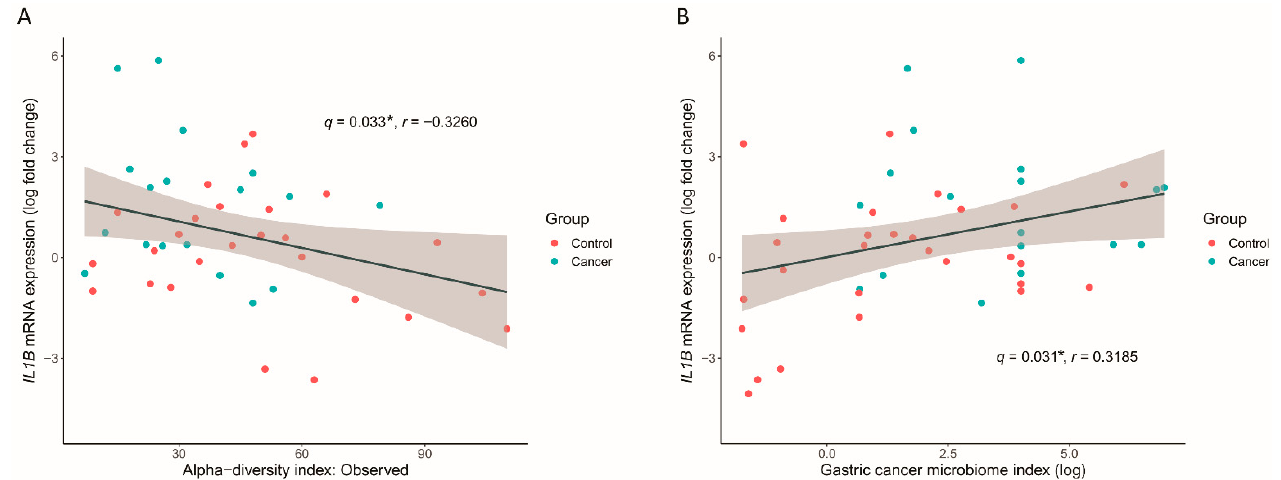
Figure 7. Significant correlation between the microbial profiles and IL1B mRNA expression levels. ( A ) Correlation of α -diversity index, observed index, with relative IL1B mRNA expression levels, were evaluated using Pearson’s correlation of log transformed values. ( B ) Relative abundance of Campylobacter, Lacticaseibacillus, and Haemophilus were combined to derive a gastric cancer microbiome index. Correlation of this index with the IL1B mRNA expression was assessed. * q < 0.1.